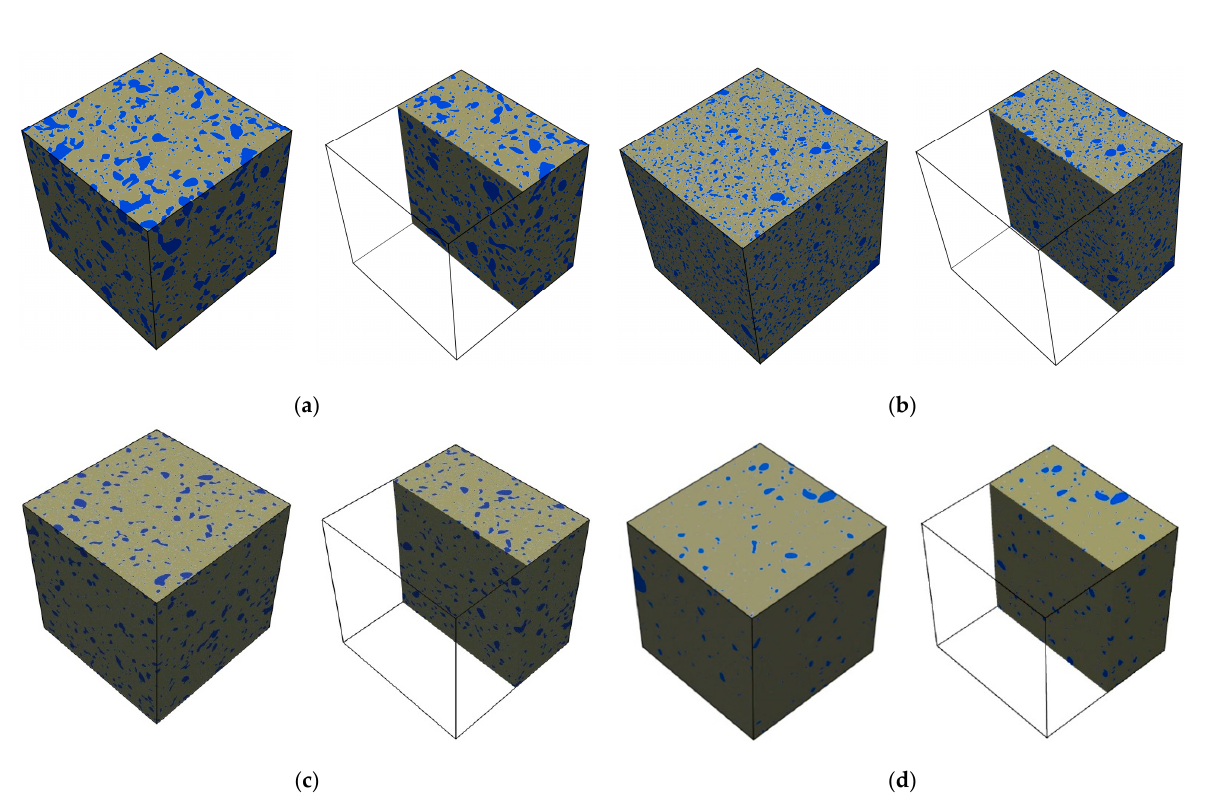
Figure 10. Generated models of the four invested rocks (pores—blue, matrix—grey). ( a ) Boom clay model; ( b ) COx argillite model; ( c ) Opalinus clay model; ( d ) Beishan granite model.